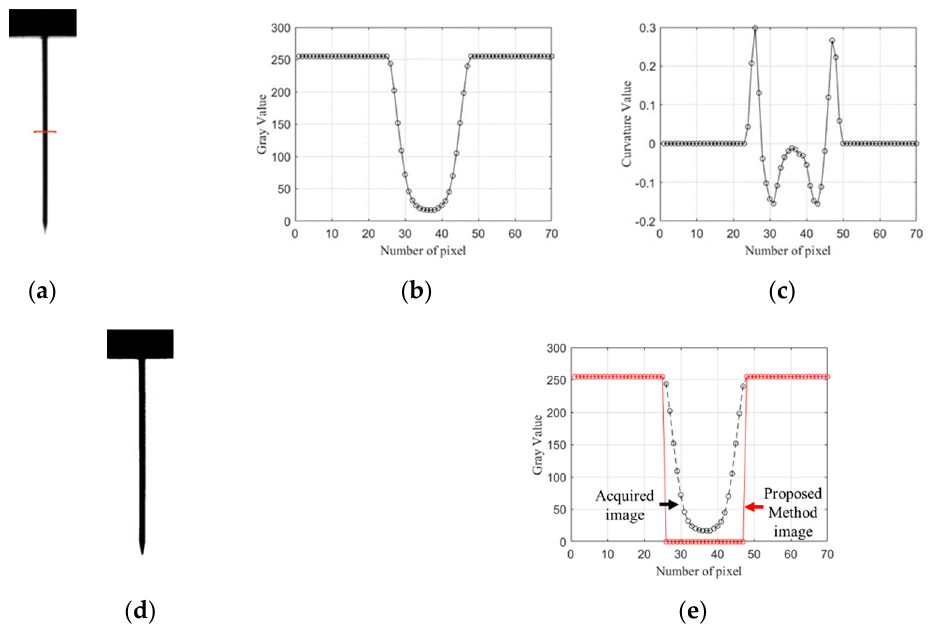
Figure 5. ( a ) Acquired image; ( b ) gray values line profile; ( c ) curvature values line profile; ( d ) proposed